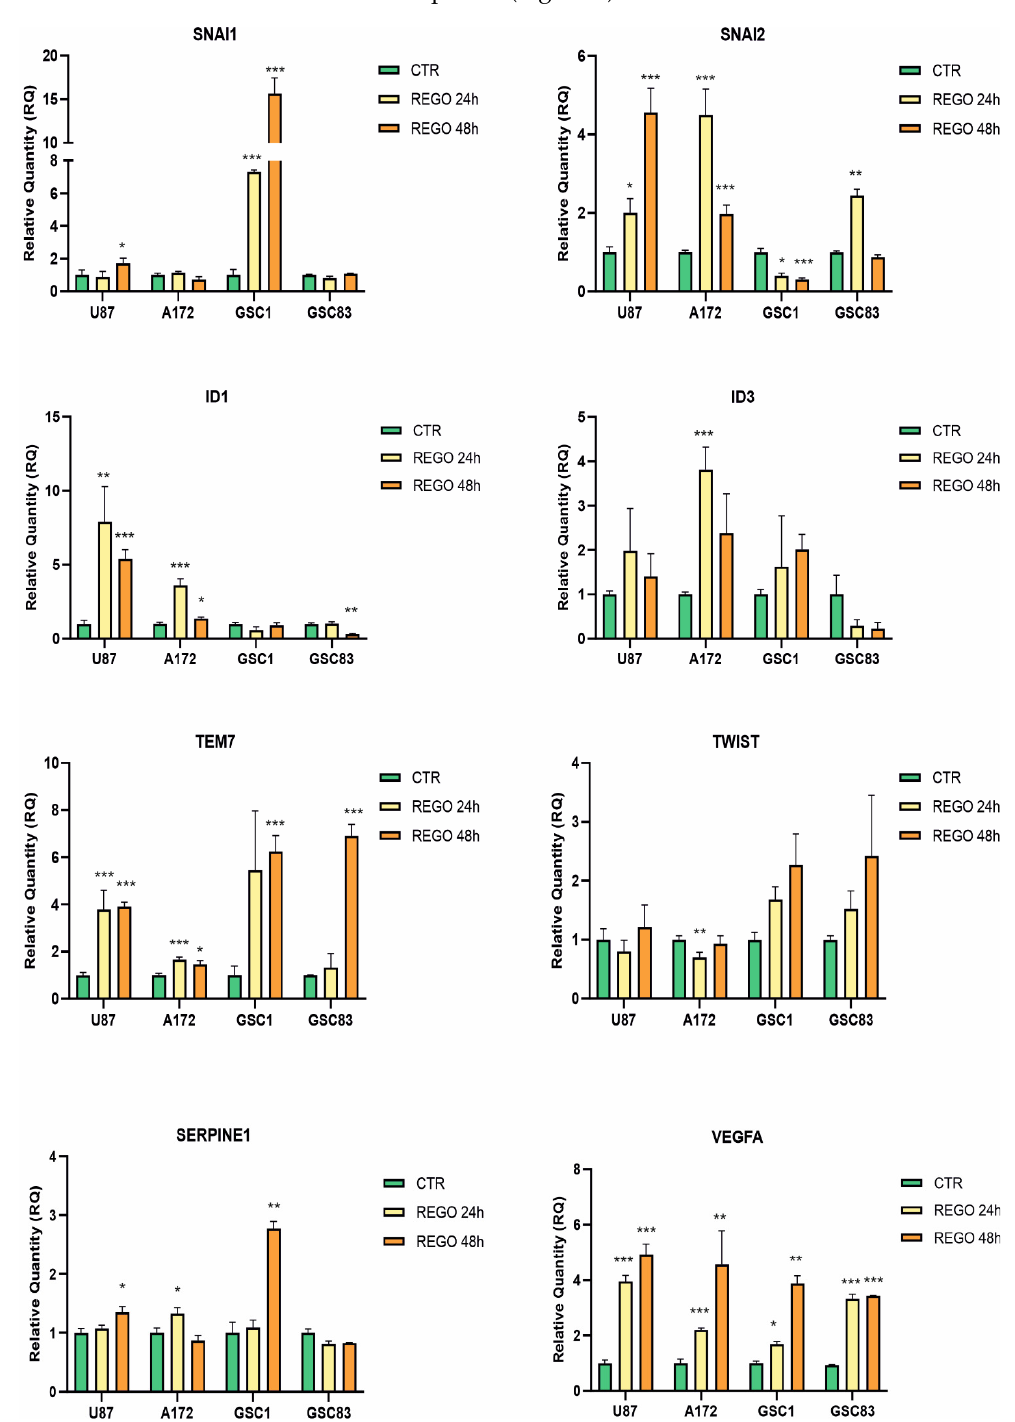
Figure 5. Gene-expression changes upon regorafenib treatment. Real-time PCR analyses of a pool of EMT-related genes, performed on both GBM cell lines and patient-derived GSCs. Cells were treated with 7.5 µ M regorafenib for 24 and 48 h. Relative quantities were calculated normalizing for TBP and are given relative to control (vehicle-treated) cells. n = 3 biological replicates. * p value < 0.05; ** p value < 0.01; *** p value <